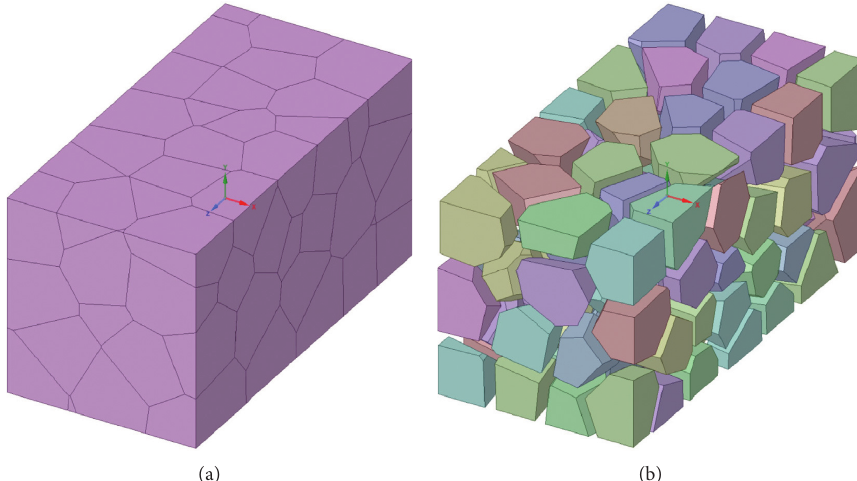
Figure 2: Random polyhedron and cell wall generation process. (a) Random polyhedron generation. (b) Generation of three-dimensional cell wall